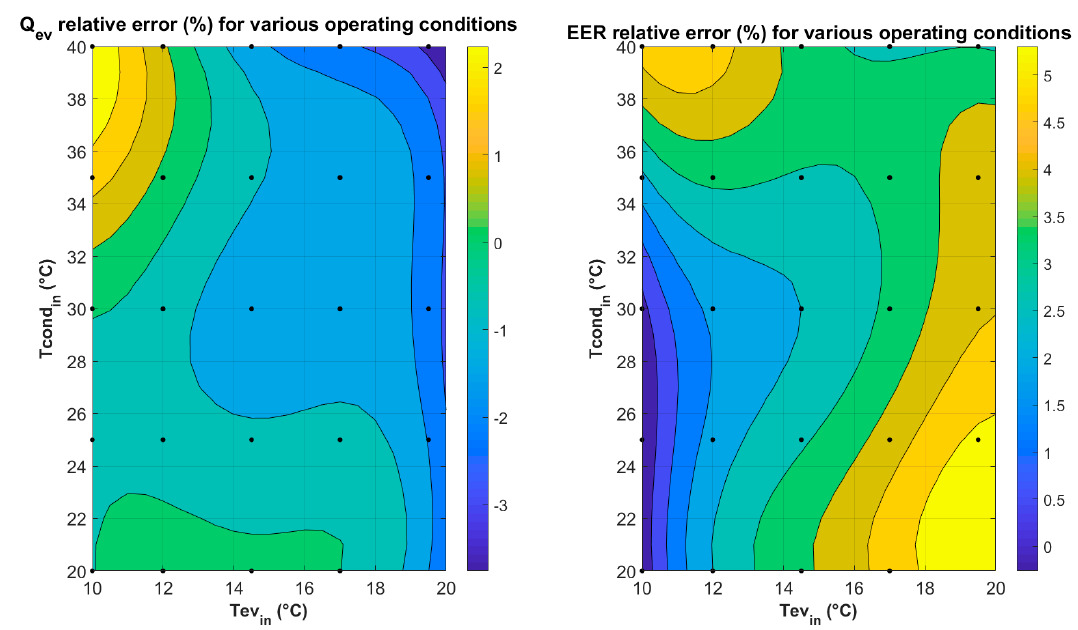
Figure 9. Compression chiller validation results in terms of relative errors (%) for the evaporator capacity and the EER under various inlet water temperatures. 6. Hybrid System Integrated Model: Results